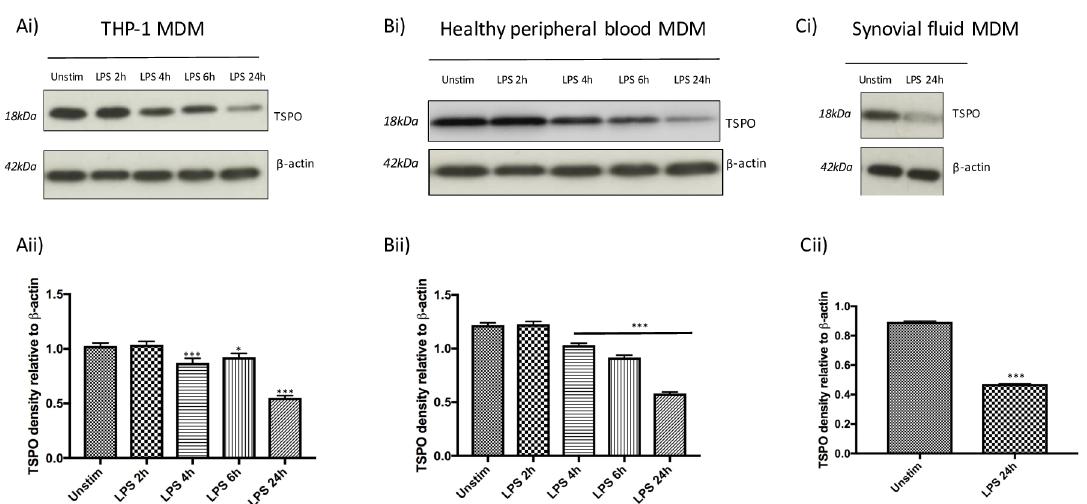
Fig 6. Western blotting indicates TSPO protein expression decreaseson treatment of MDM with M1 stimuli LPS plus IFN- γ . (i) representative western blot of TSPO protein with β -actin acting as loadingcontrol and (ii) densitometry normalized to β -actin in ( A) THP-1 MDM, ( B) healthy peripheral blood MDM and ( C) synovialfluid MDM either unstimulated ( unstim )or treated with 10ng/mL LPS plus 20ng/mL IFN- γ ( LPS ) for 2,4,6 and 24 hours. Densitometry data is expressedas the mean of five independentexperiments ± SEM. ( * p < 0.05, ** p < 0.01, *** p (cid:20)